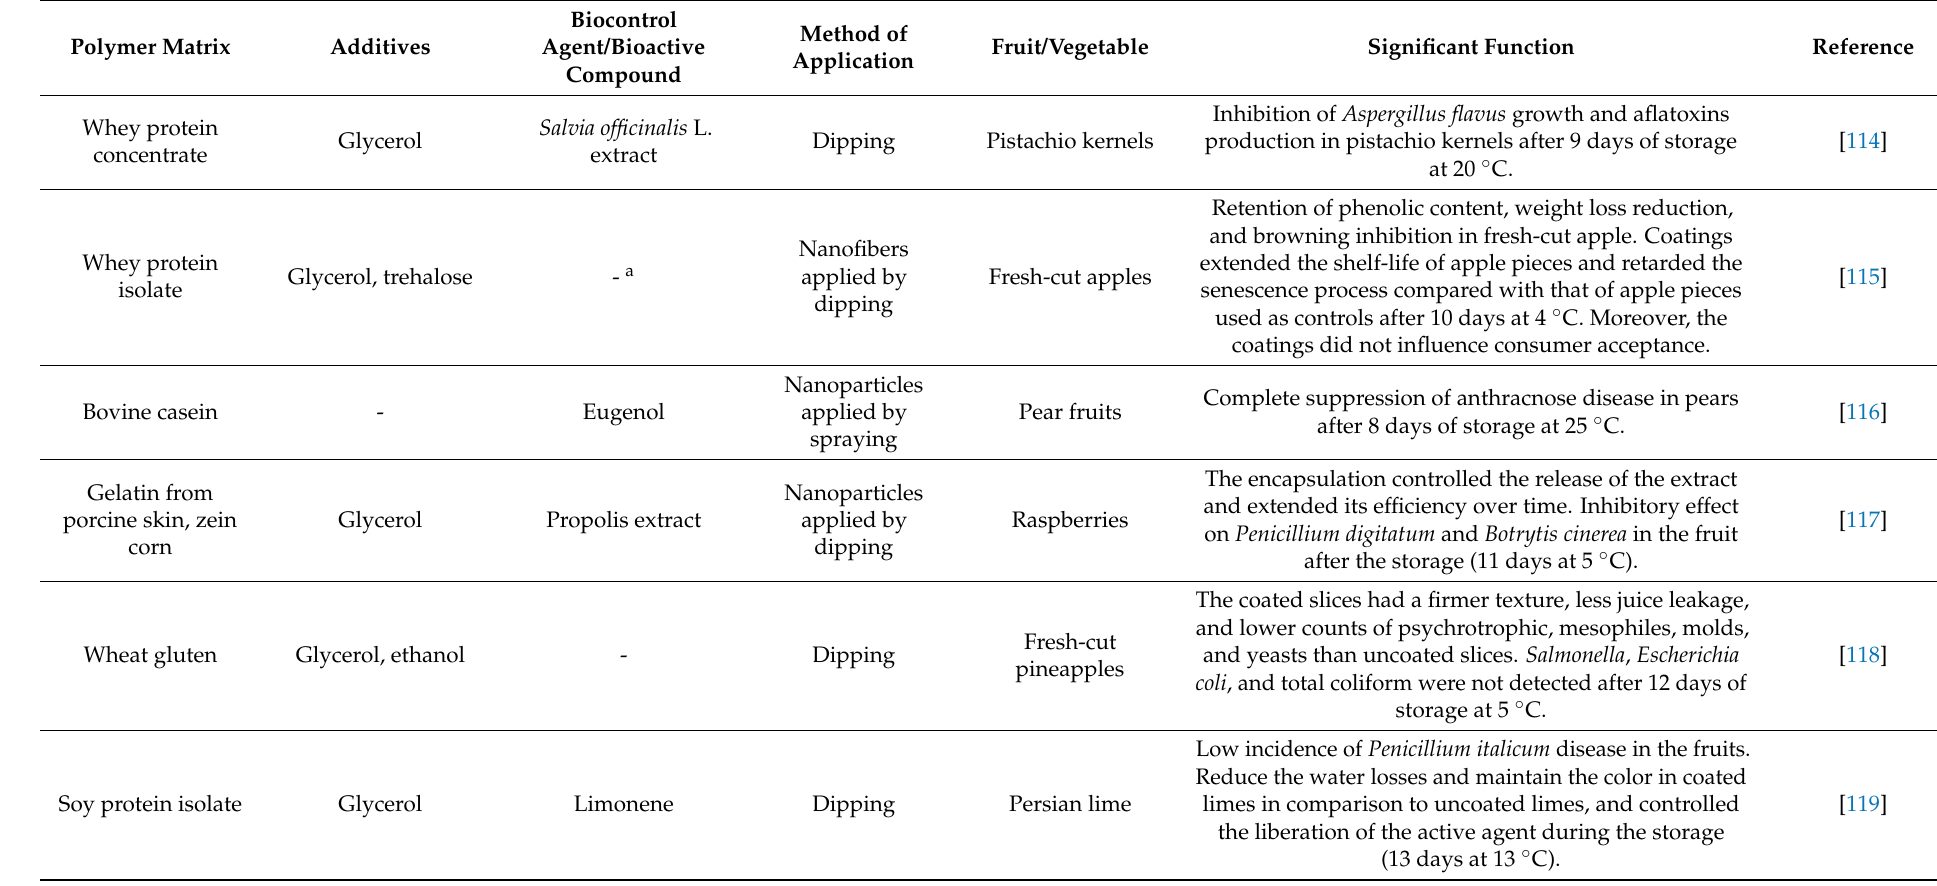
Table 2. Protein-based coatings for different fresh fruit products with its